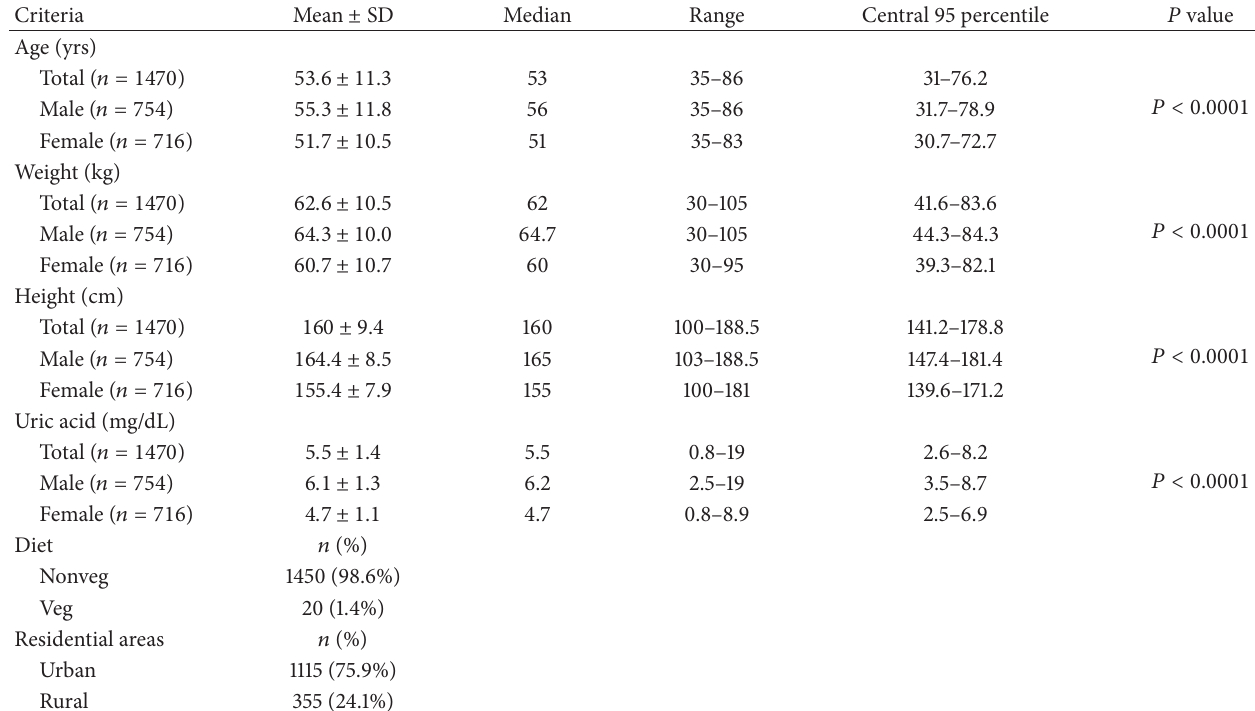
Table 5: The results of the selected characteristics of the target population.